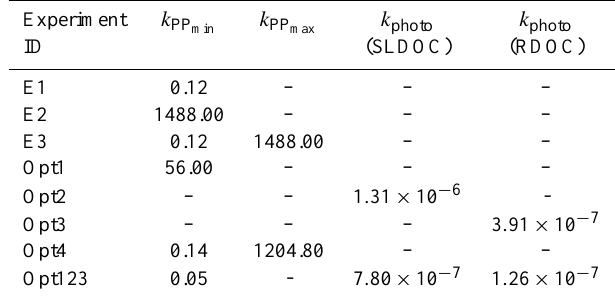
Table 2. CH 3 I model parameter configurations of the different ex- periments. The unit of k PP is [mmolCH 3 I ( kmolP ) − 1 ], the one